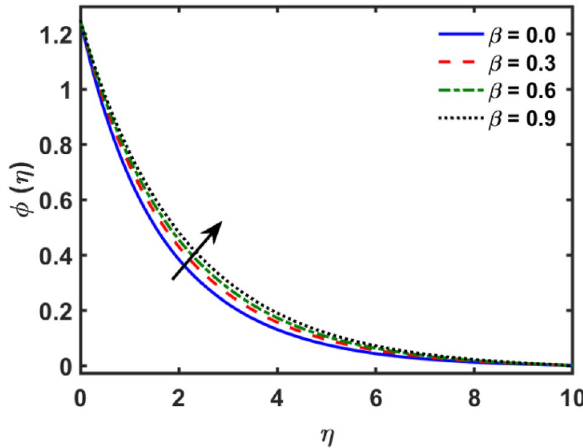
Figure 13. Variation of β on φ(η) .